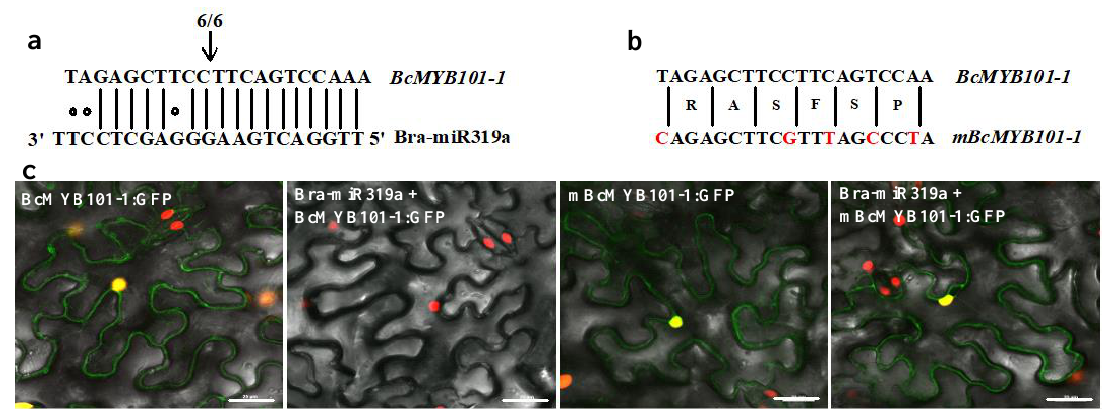
Figure 7. Specific regulation of BcMYB101-1 by Bra-miR319. ( a ) Validation of the target gene BcMYB101-1 of Bra-miR319 in B. campestris by 5′ RACE. ( b ) Construct of a version of BcMYB101-1: GFP with multiple mutations in the miRNA complementary motif. ( c ) Effects of Bra-miR319a on BcMYB101-1: GFP fluorescence in Nicotiana benthamiana leaf epidermal cells.